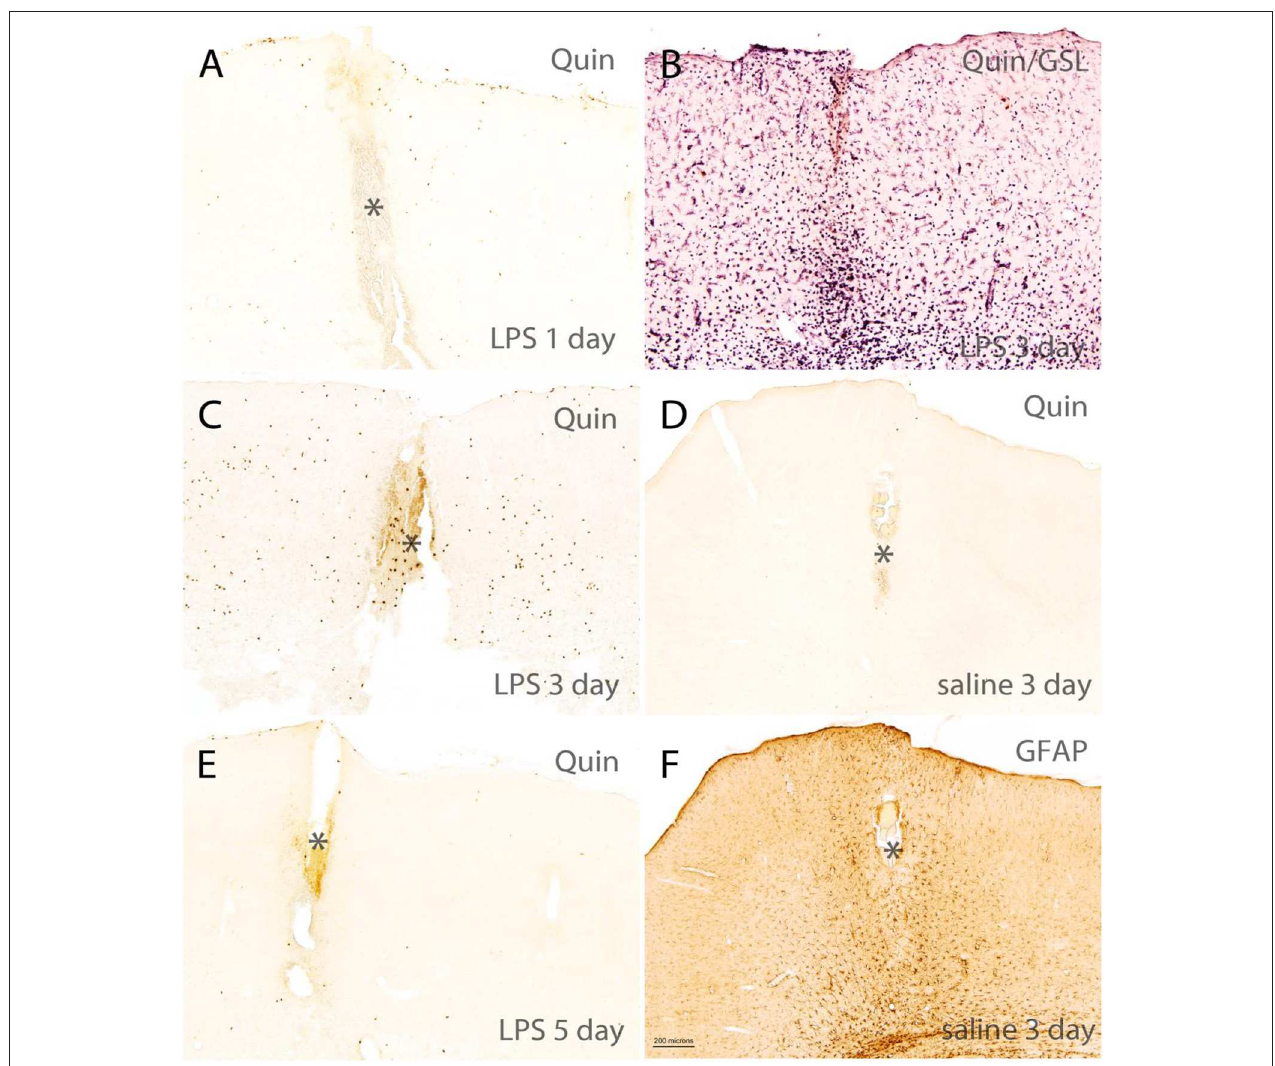
FIGURE 6 | Short-term time course of reactions in rat brain cortex after intracerebral injection of LPS. (A,C,E) Show Quin-IR around the injection site in cortex at 1, 3, and 5 days after LPS administration. (B) Shows staining for the lectin GSL-IB 4 (purple chromogen) and Quin (orange chromogen) 3 days after LPS injection, demonstrating the dramatic microglial and macrophage response at 3 days post-injection. (D) Shows Quin-IR at the injection site 3 days after saline injection into the hippocampus. (F) Shows a moderate astrocyte response (glial acidic fibrillary protein: GFAP) around the injection site 3 days after saline administration, given as control. In the LPS-injected rats, GFAP staining in the damaged area near the injection site was reduced due to astrocyte death. *Injection tract in cortex. Bar in (F) , 200 µ m in all panels. The orange color in the injection tract is due to hemoglobin in red blood